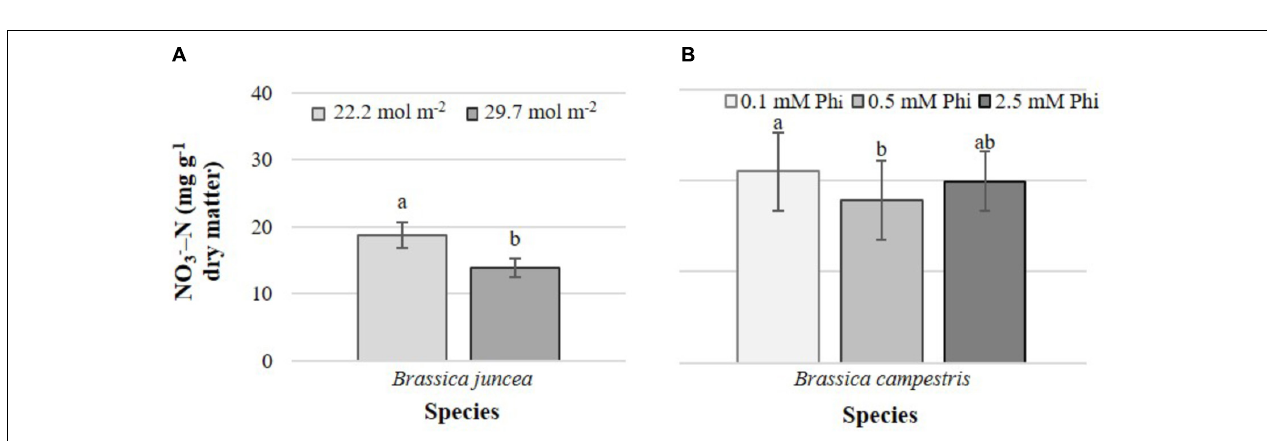
R 2 = 0.576 ( Figure 6 ). The same relationship was non-significant in B. juncea ( R 2 =